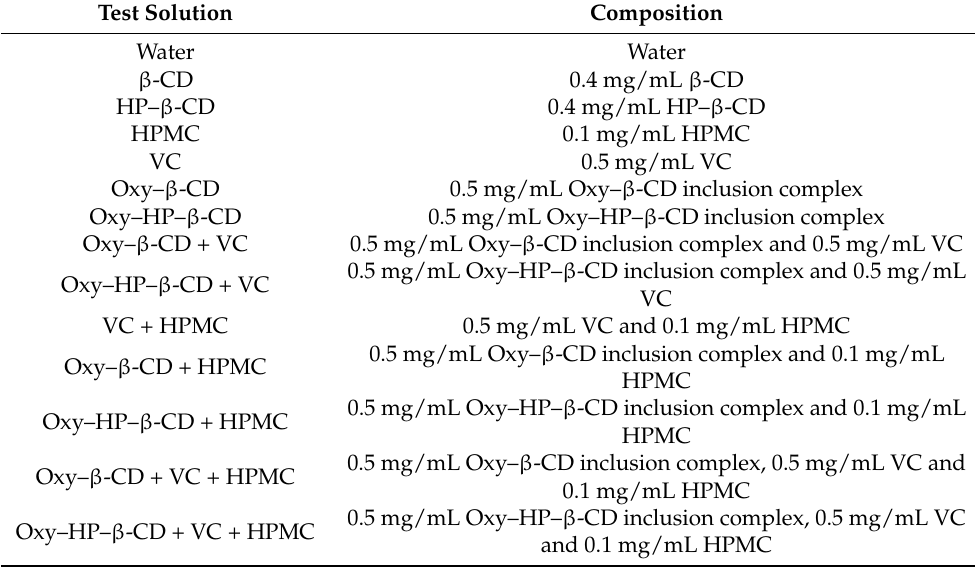
Table 1. Each experimental group solution for processing apple